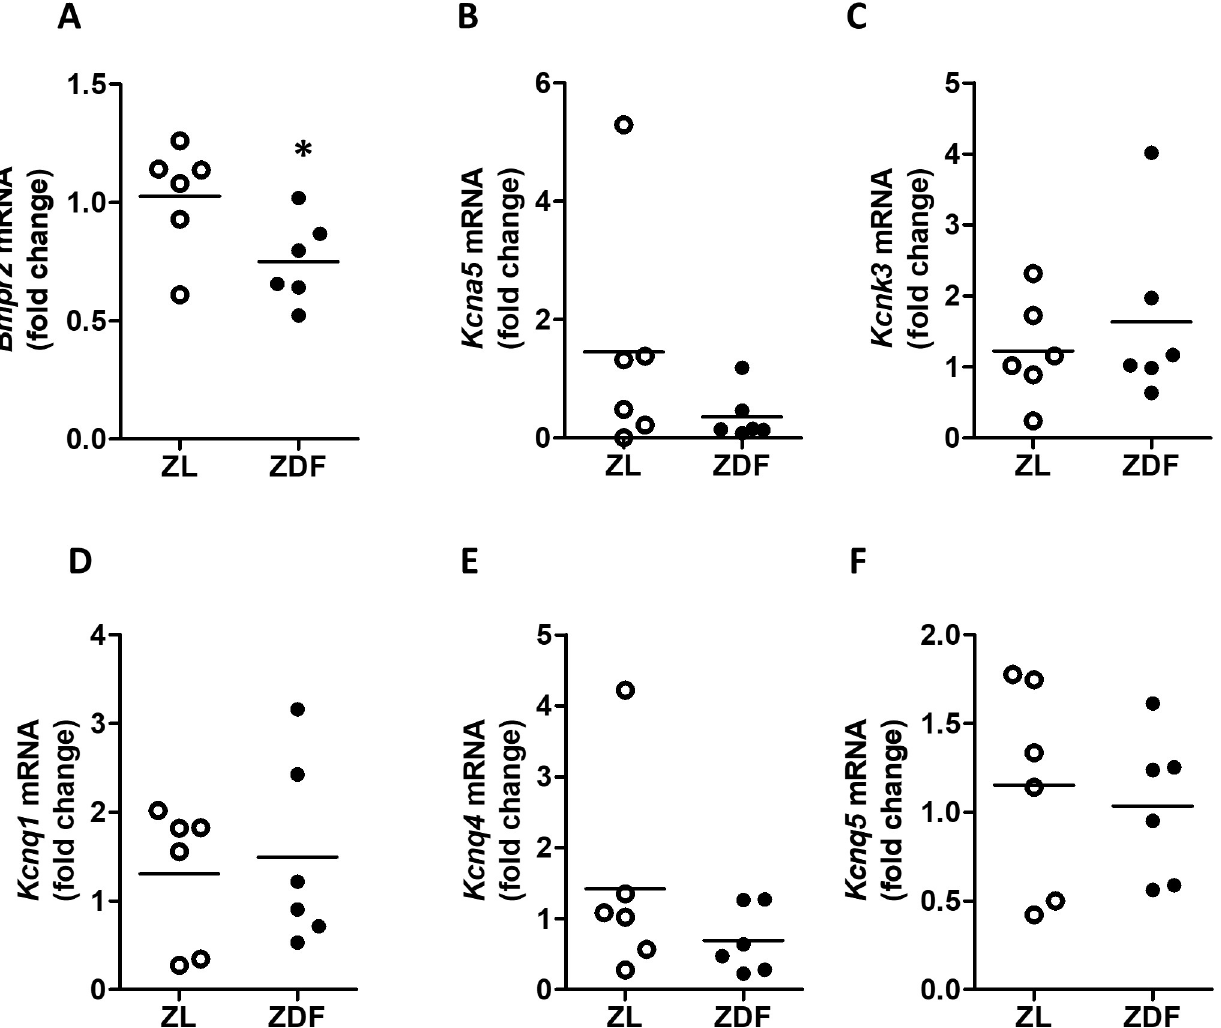
Fig 6. Changes in mRNA expression of (A) Bmpr2 , (B) Kcna5 , (C) Knck3 , (D) Kcnq1 , (E) Kcnq4 and (F) Kcnq5 mRNA. Expression was analyzed by qRT-PCR. Results are scatter plots and means of 6 animals normalized by the expression of β -actin and β 2-microglobulin. Results are expressed as scatter plots and means of 6 animals. � indicates P < 0.05 ZDF versus ZL (unpaired t test).